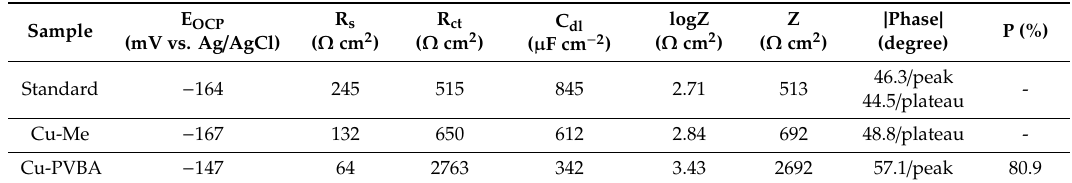
Table 1. Electrochemical parameters calculated from electrochemical impedance spectroscopy recorded at room temperature in 0.9% NaCl solution for standard copper, methanol-treated copper, and PVBA modified